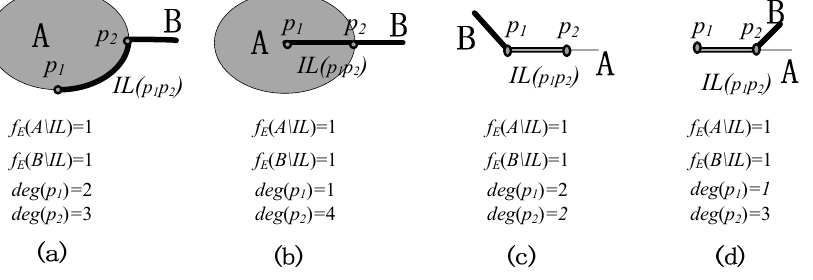
Figure 5. Examples of 1-dimensional intersection relations of line/region and line/line that cannot be distinguished by “Euler number”, i.e., f E ( A\IL ) and f E ( B\IL ), but can be distinguished by “de- gree of point”.( a ) Region A intersects line B with a intersection-line on the boundary; ( b ) Region A intersects line B with a intersection-line inside region A; ( c ) One case that line A intersects line B with a intersection-line; ( d ) The other case Line A intersects line B with a intersection-line.